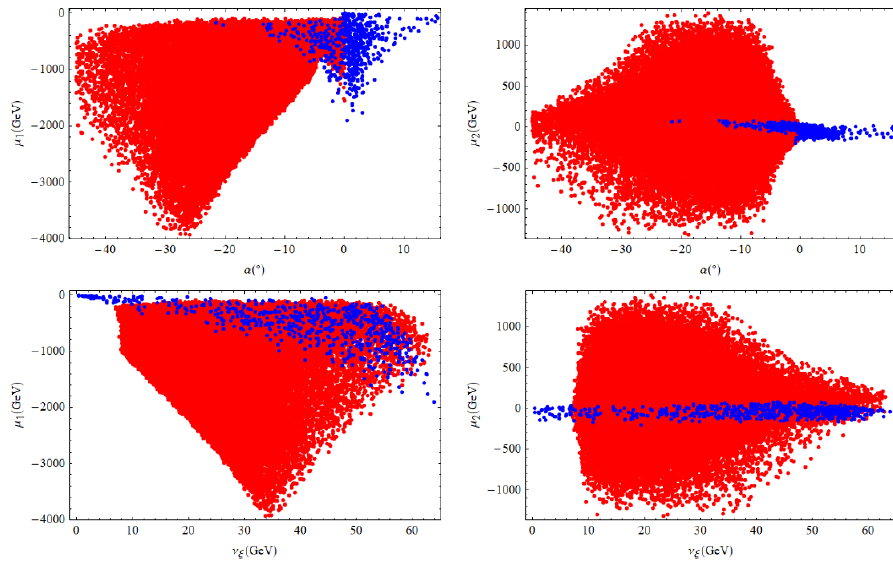
Figure 4 . The SFOEWPT viable points in the parameter spaces of (cid:11) and (cid:22) 1 (upper-left), (cid:11) and (cid:22) 2 (upper-right), (cid:23) (cid:24) and (cid:22) 1 (below-left) and (cid:23) (cid:24) and (cid:22) 2 (below-right). The blue and red points satisfy the two step phase transition and one-step SFOEWPT conditions.